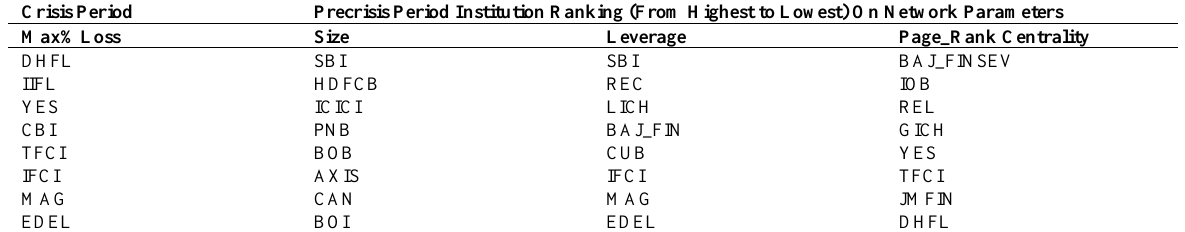
Table 5. Comparison of top twenty financial institutions based on Max%Loss from crisis period and Granger- causal-network-based measures from the pre-crisis